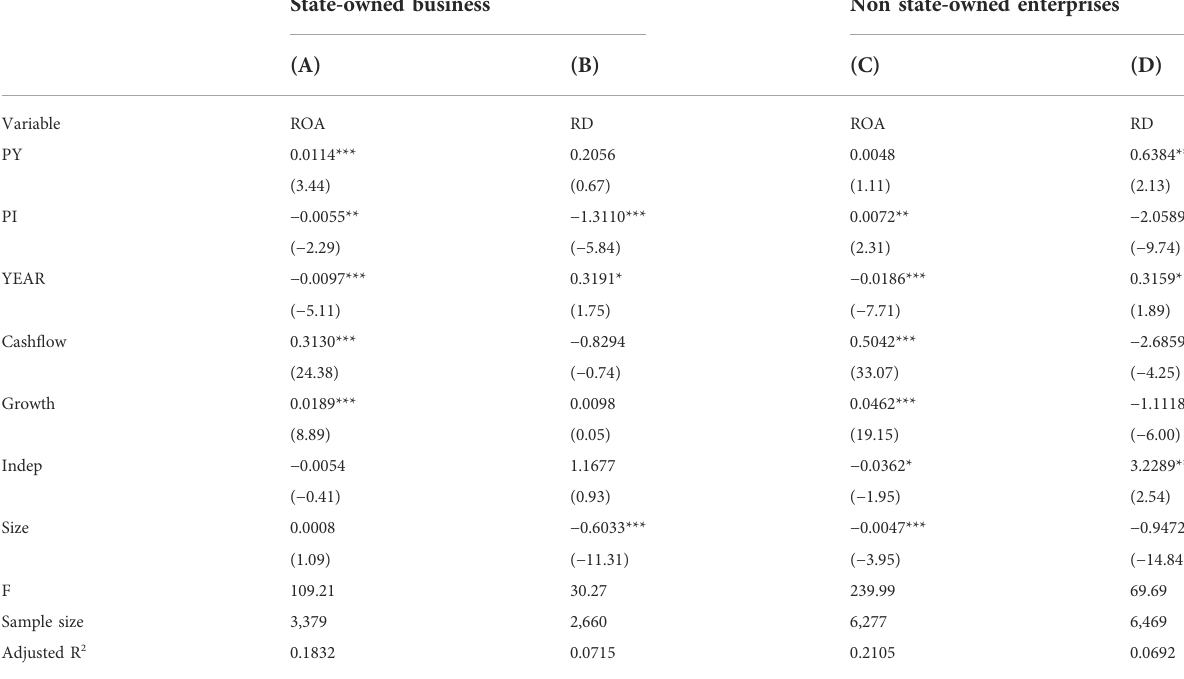
TABLE 5 Regression results for companies with different property rights.